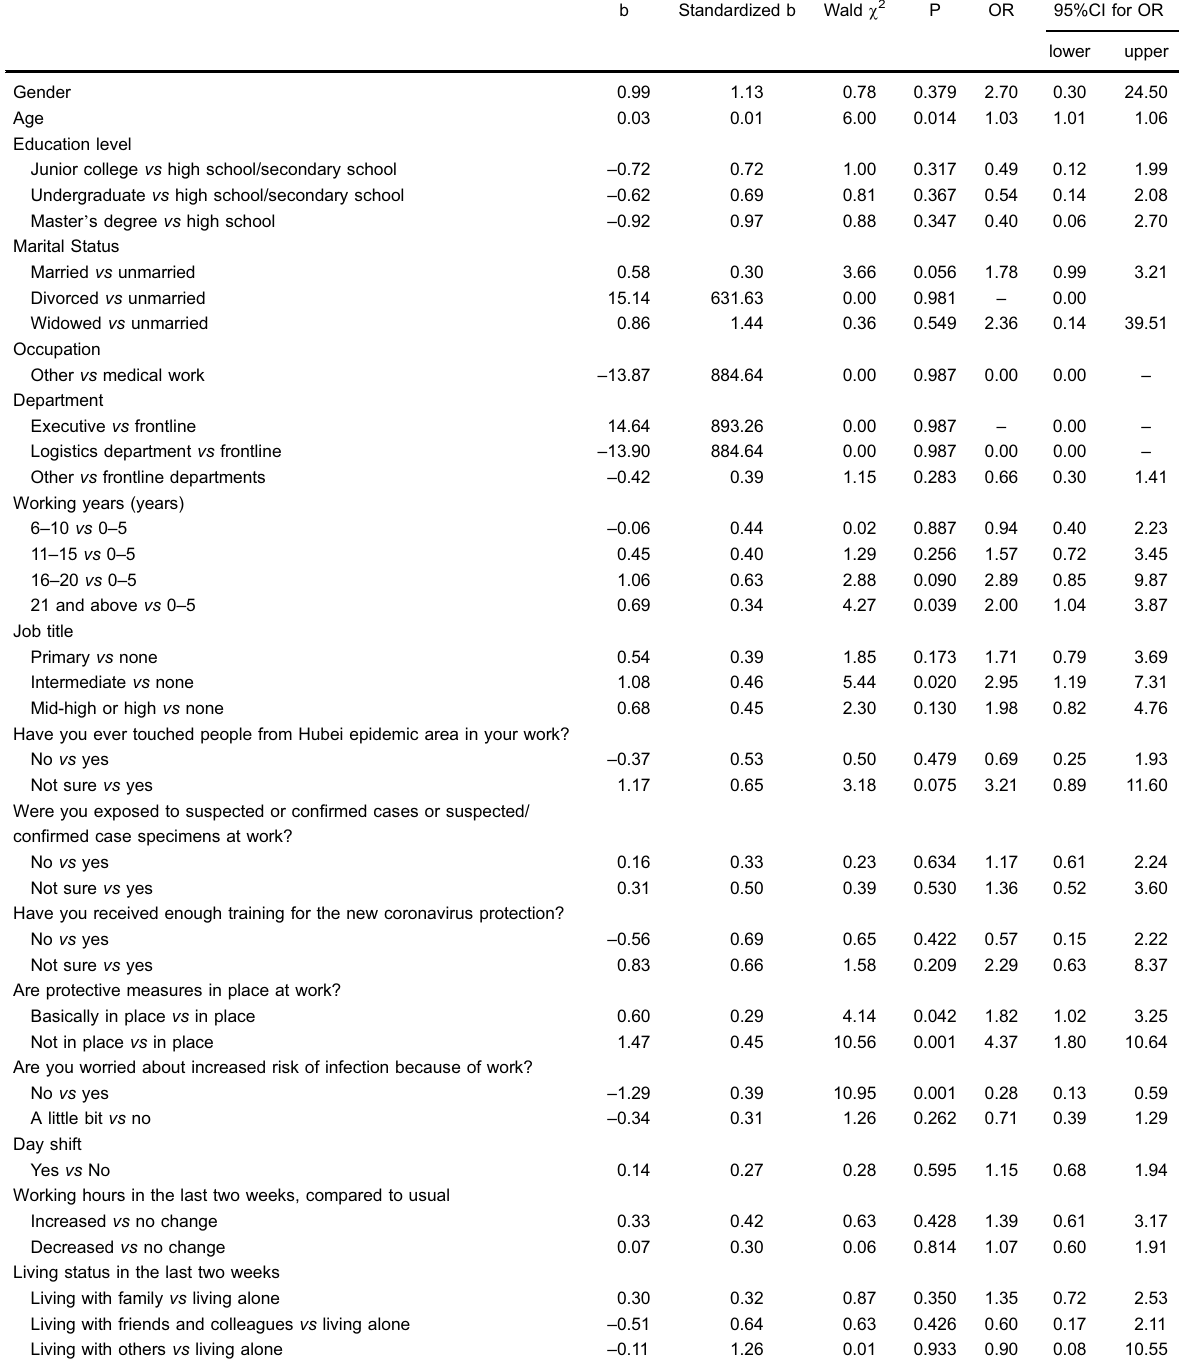
Table 3. Univariate regression analysis of factors associated with insomnia in healthcare workers during the COVID-19